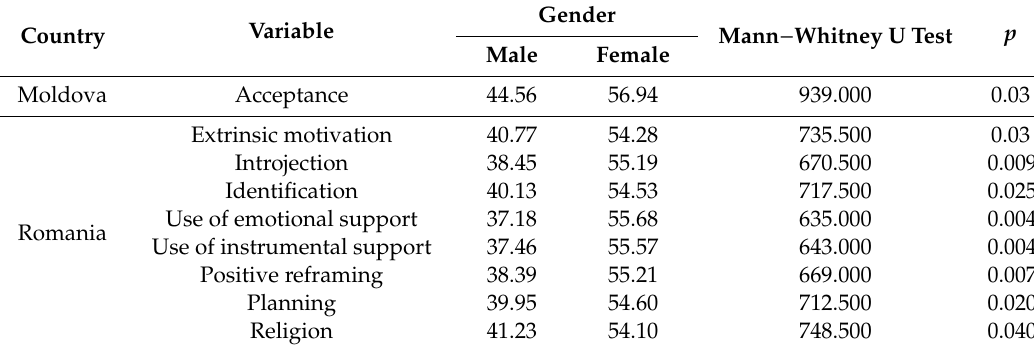
Table 2. Gender di ff erences in Moldova and Romania.